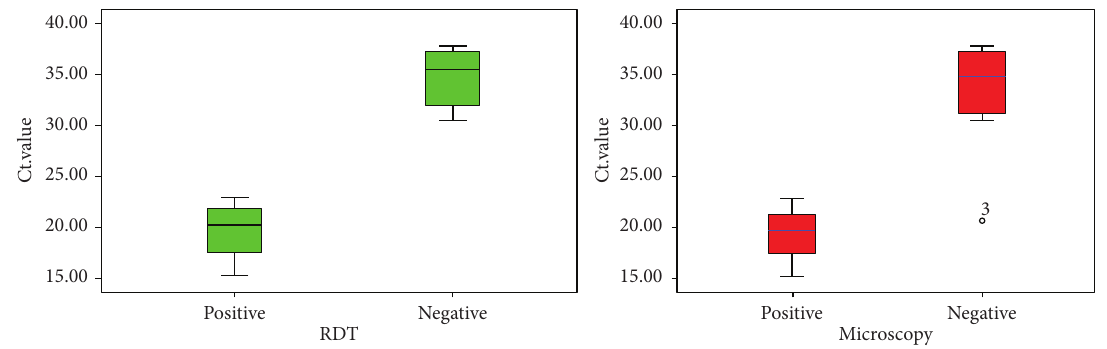
Figure 6: Box plots diagram representing RDT and microscopy results with the Ct value of real-time PCR. Table 3: Summary table representing the comparison of real-time PCR cycle threshold (Ct) value with the positive results of microscopy and the